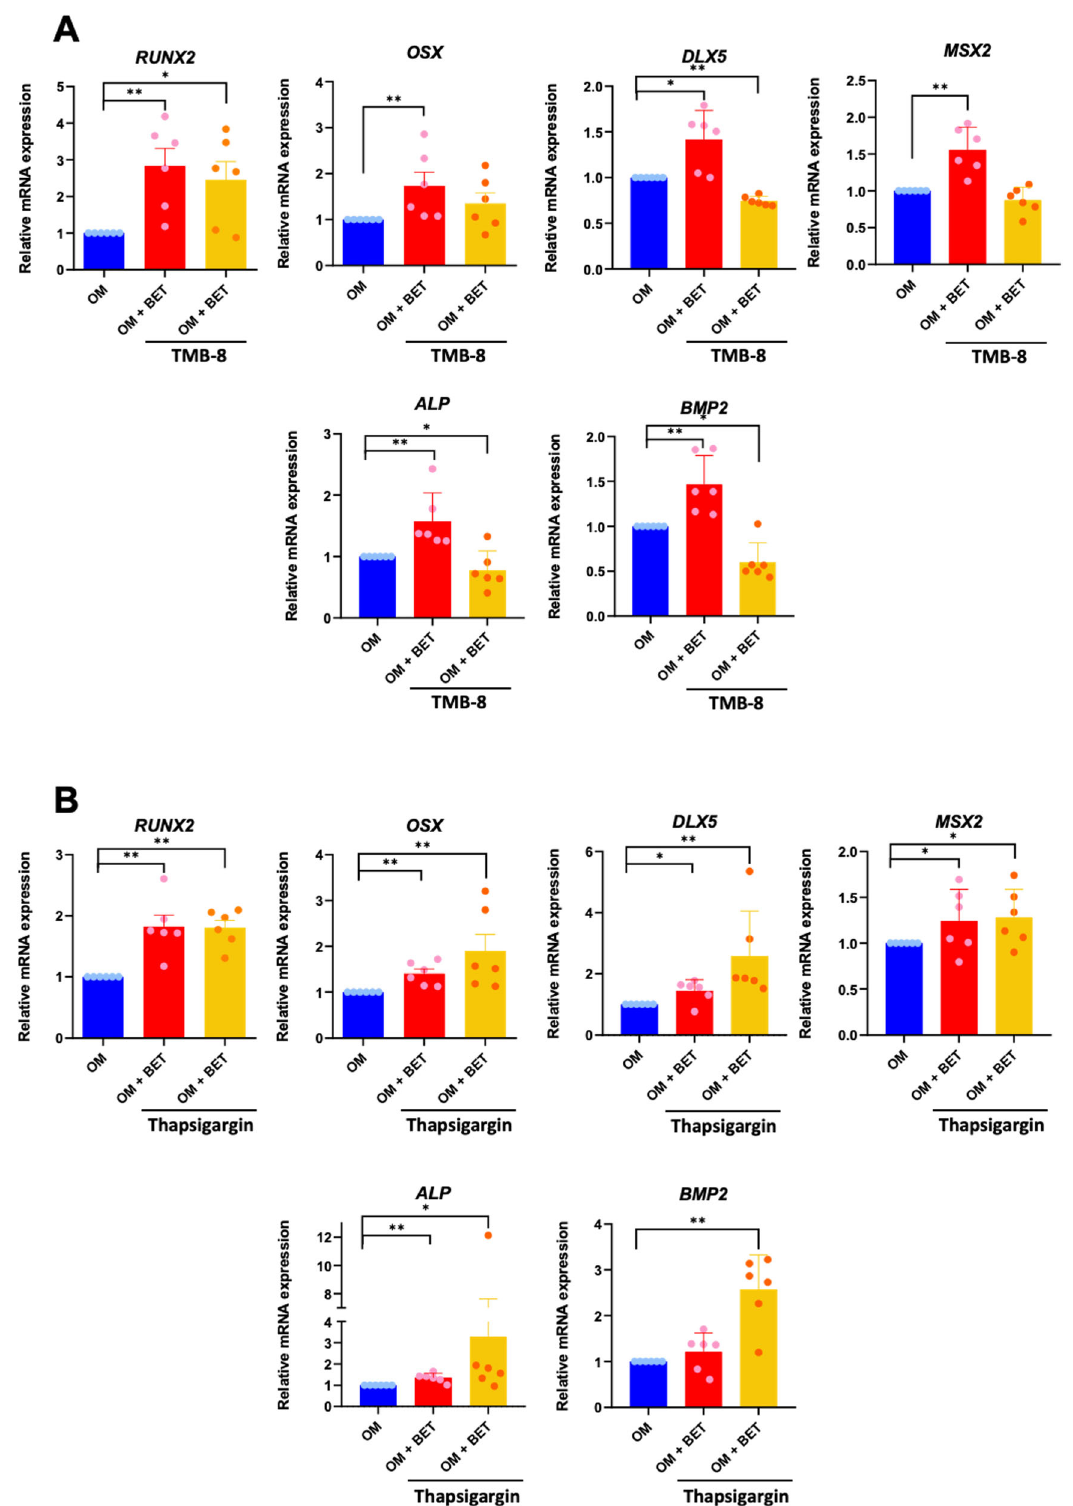
Fig. 4 In fl uence of BET on calcium in fl ux. ihDPs were pretreated with either 50 µM TMB-8 or 10 µM thapsigargin for 30 min prior to stimulating with 50 mM BET for 3 h. The mRNA expression of osteogenic-related genes was examined using a real-time polymerase chain reaction ( A , B ). Bars indicate a signi fi cant difference between groups (* P < 0.05, ** P <